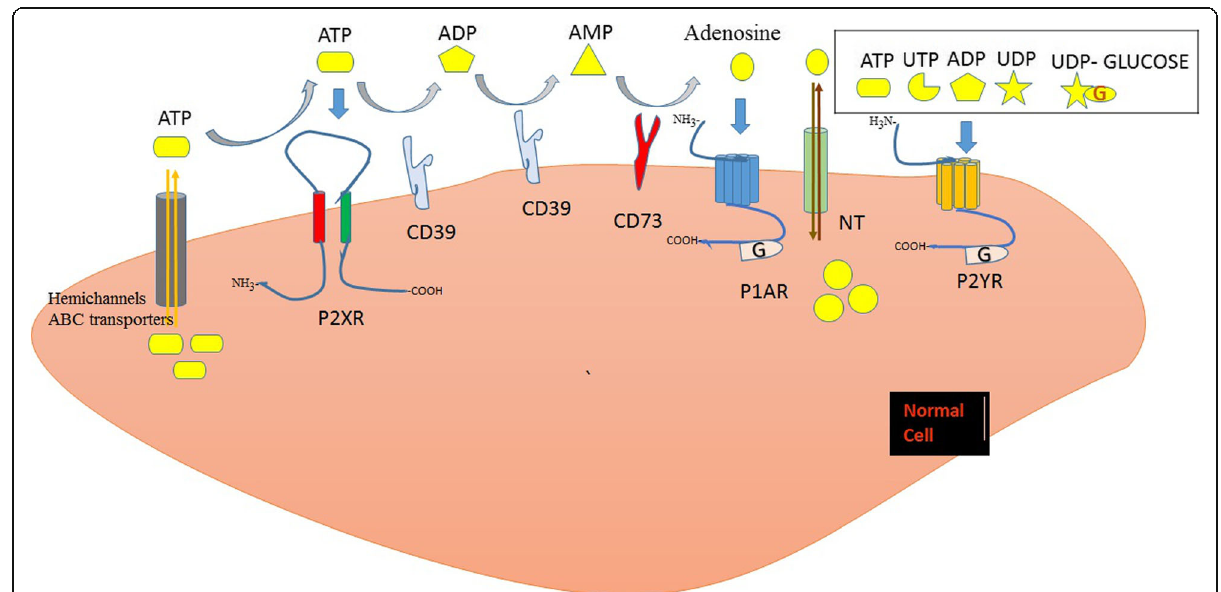
Fig. 1 General outline of purinergic signalling in ovarian cancer. In a tumour cell, ATP is released into the extracellular milieu either through connexion or pannexin hemichannel or by ABC (ATP binding cassette) transporter proteins. Presence of ATP in the extracellular milieu activates the P2X and P2Y purinergic signalling cascade. Extracellular ATP is soon hydrolysed by ectonucleotidases CD39 (conversion of ATP/ADP to AMP) and CD73 (conversion of AMP to adenosine) generate adenosine; it will activate the purinergic P1 adenosine receptors. This extracellular adenosine is transported into the cell through nucleoside transporter proteins. P2X purinoceptor is activated by the presence of ATP and that of P2Y purinoceptor is activated by the presence of ATP, UTP, ADP, UDP and